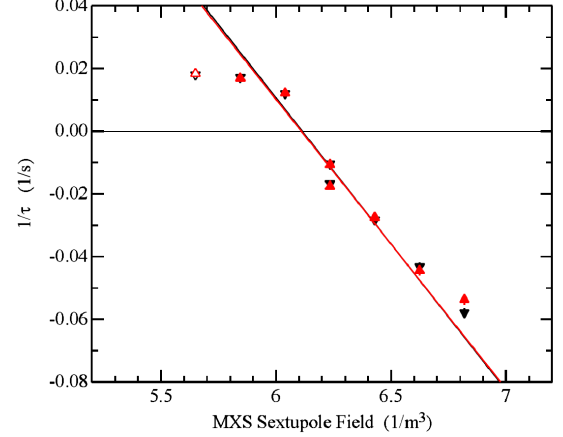
FIG. 16. Same as Fig. 15 but for wide beam scan 2, shown as a function of S ( G is zero). This is a subset of the data shown in